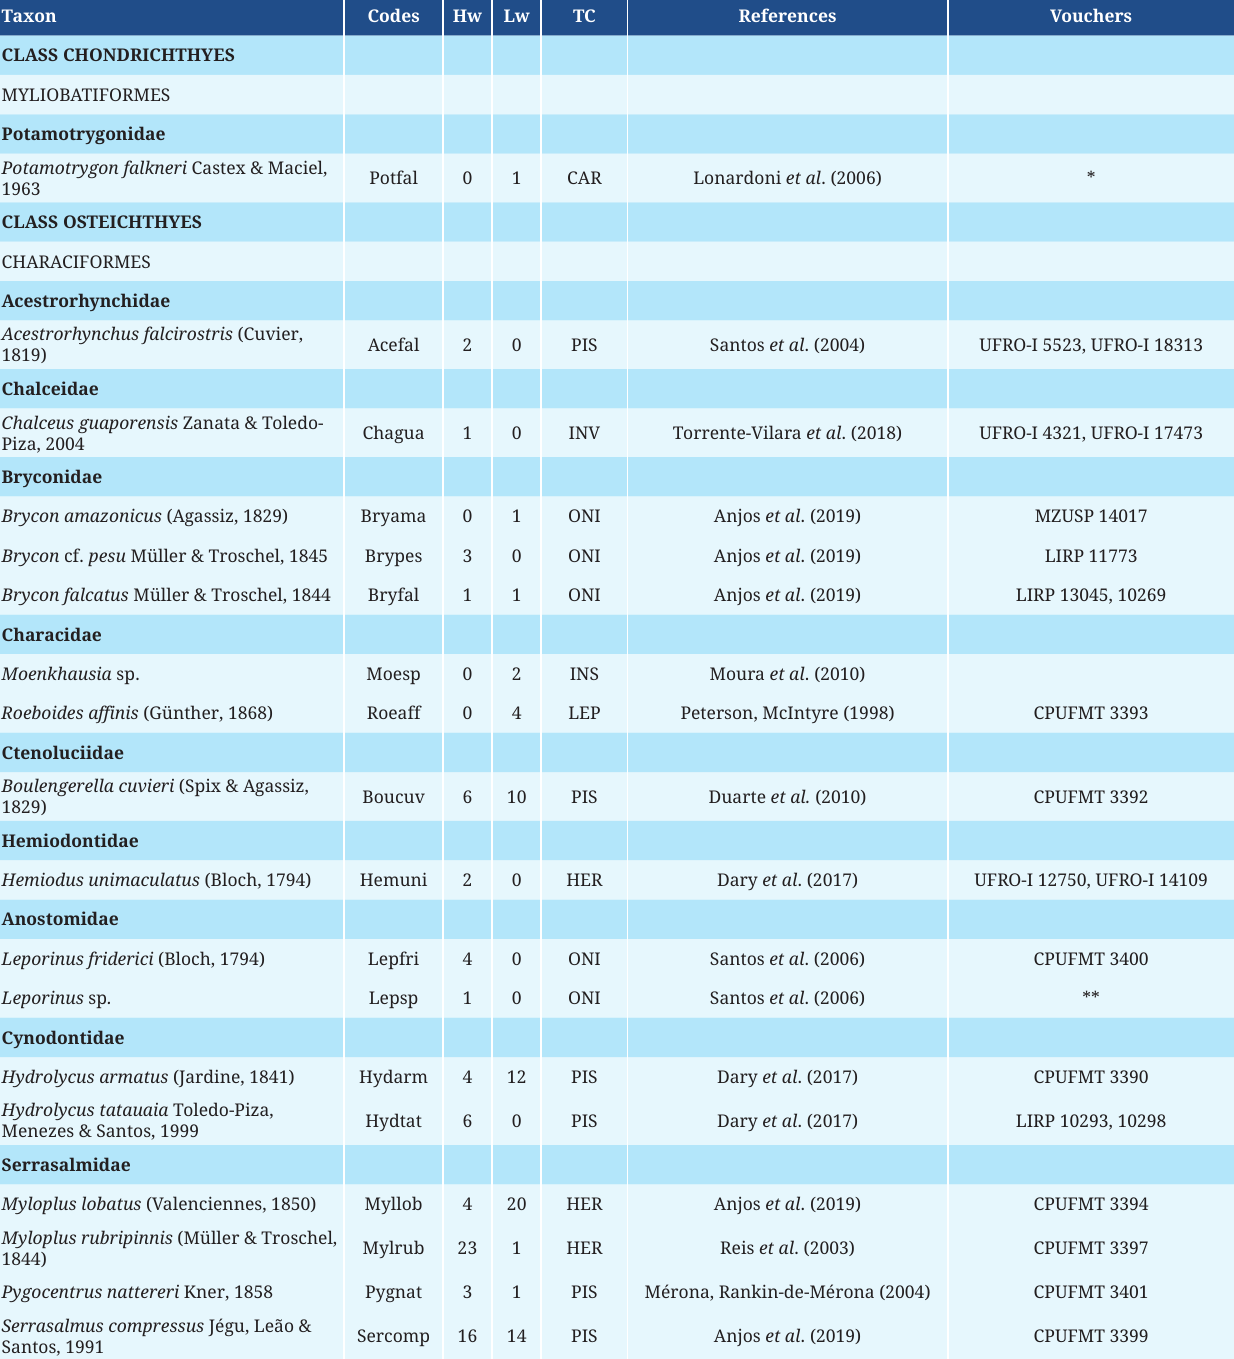
TABLE 2 | Taxons, species code, numerical abundance of the species sampled during the high water (Hw) and low water (Lw) seasons, trophic categorization (TC) (CAR = Carnivores, DET = Detritivores, HER = Herbivores, ILI = Iliophagous, INS = Insectivores, INV = Invertivores, ONI = omnivores, PIS = piscivorous, PLA = planktivores, LEP = lepidophagous) and references of the species collected in the Tarumã River, Jaru Biological Reserve, Machado River basin, northern Brazil. * = in process of deposit in Museu de Zoologia